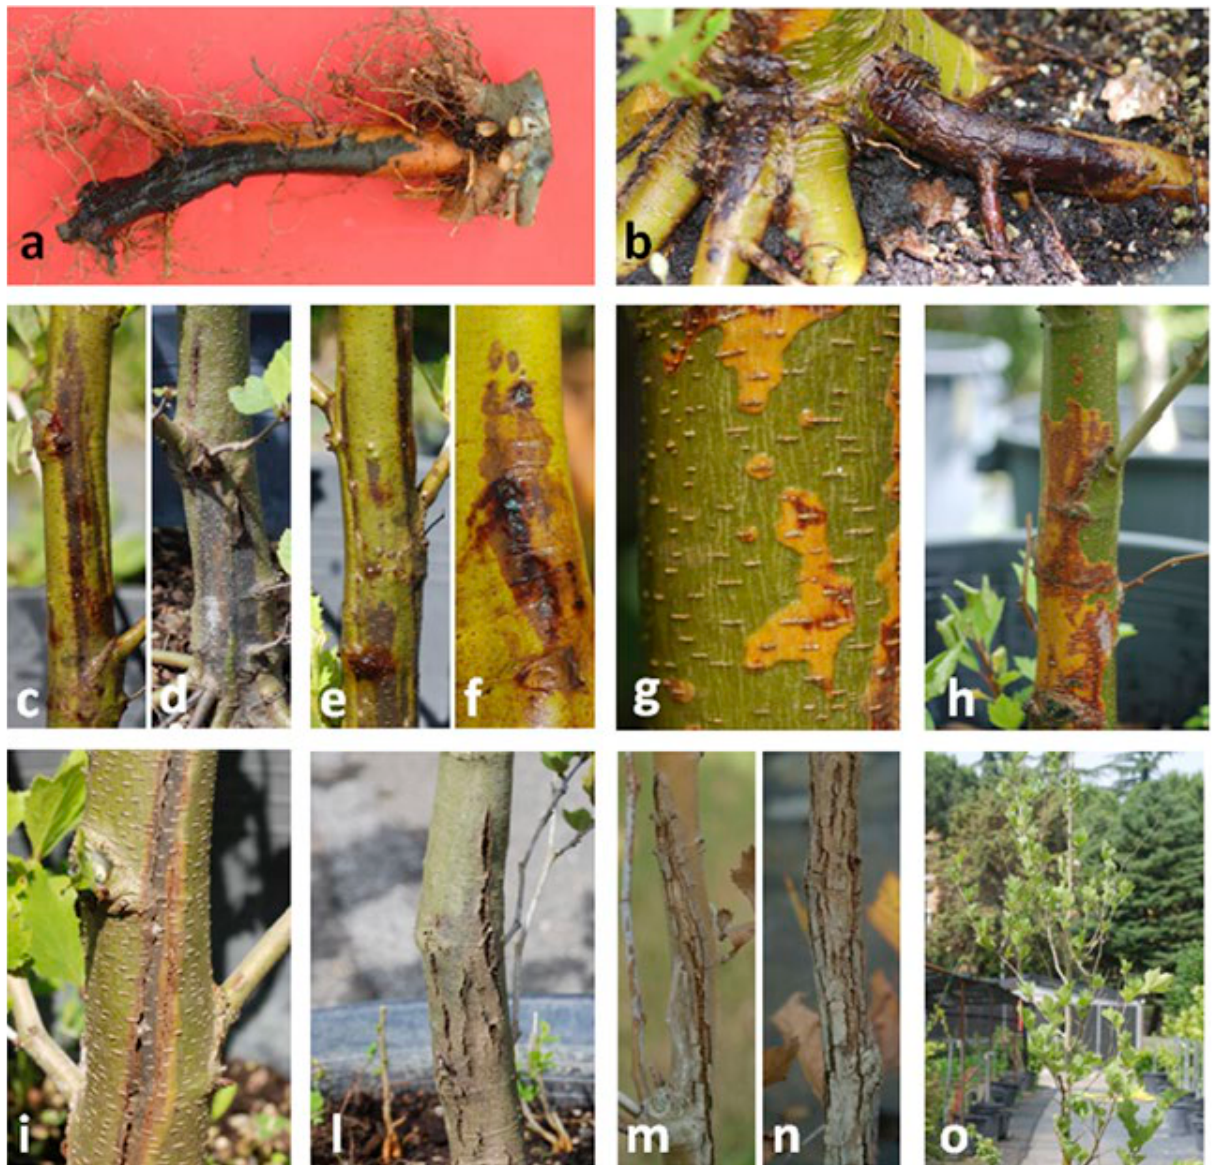
Figure 1. Symptoms of stem canker and root rot observed on nursery-grown Platanus × acerifolia trees, and associated with Phytophthora cinnamomi . Necrosis of the main roots (a, b). Bluish discolouration of the bark (c, d, e). Swollen spots turning into black and oozing blotches (e, f). Yellow/reddish/brown discolouration patterns (g, h). Healing canker with a yellow edge in the reaction zone (i). Healing/healed cankers with an irregularly-shaped callus reaction (l, m, n). Sparse foliage of a tree affected by a chronic-like course of the disease